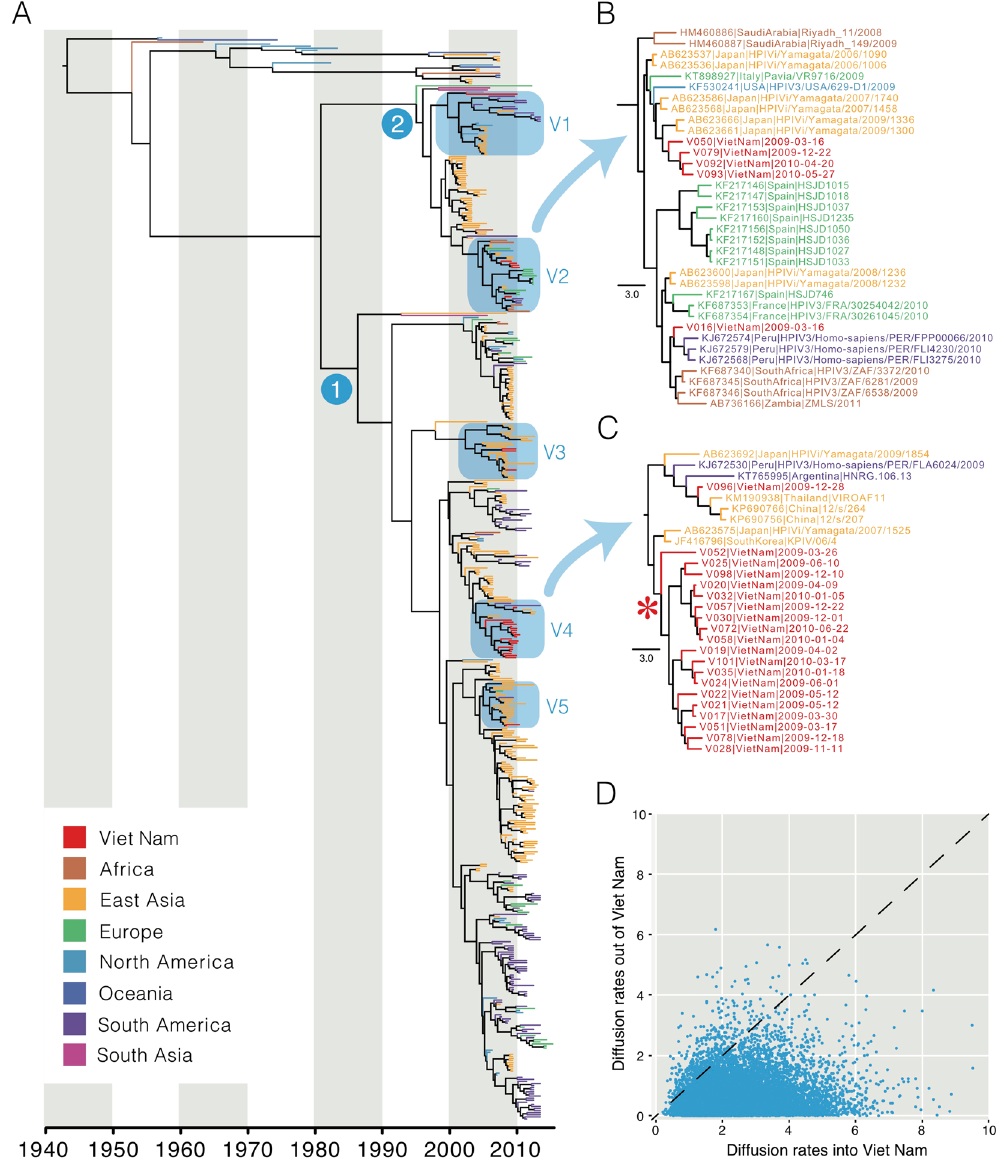
Figure 2. HPIV3 HN global phylogeny with terminal branches colored by geographical region of virus isolation ( A ). Nodes 1 and 2 indicate the common ancestors of lineages previously described in the literature. Clades containing the Vietnamese sequences generated in this study are labelled V1–V5, with clade V2 ( B ) and clade V4 ( C ) shown in detail. Within V4, a large monophyletic clade comprising sequences from Viet Nam is indicated with an asterisk. ( D ) Scatter plot of mean migration rates of HPIV3 HN in and out of Viet Nam in 2009–2010. The diagonal line indicates identical mean rates of migration in and out of Viet